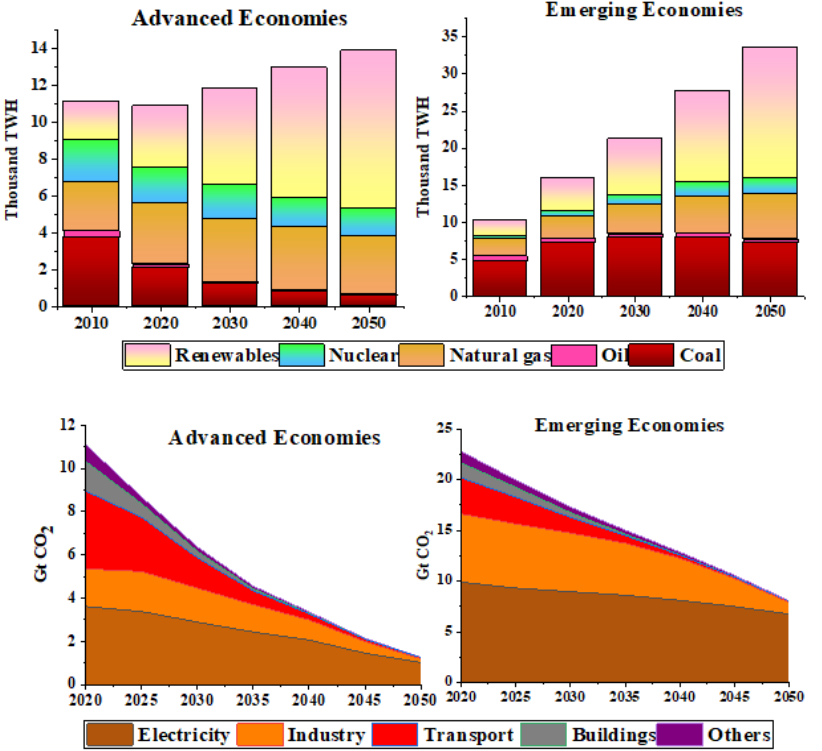
Figure 1. Energy demand and CO 2 emissions trend from the advanced and emerging economies until 2050 [10].